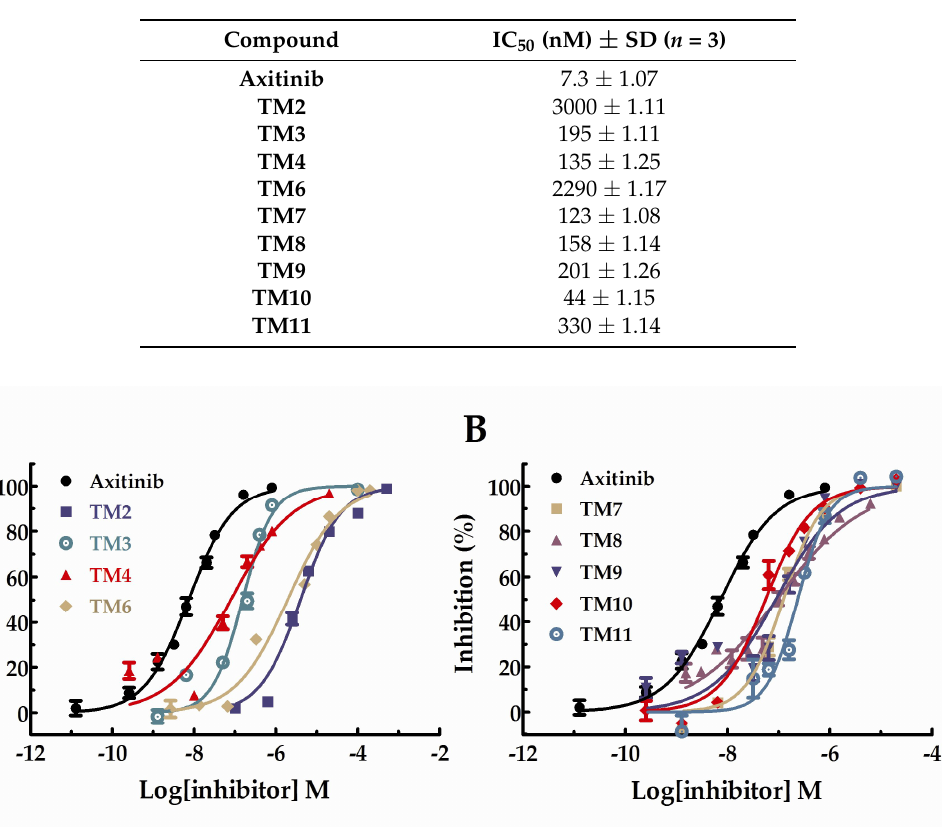
Table 1. Inhibitory activity of axitinib derivatives against VEGFR-2 kinase.